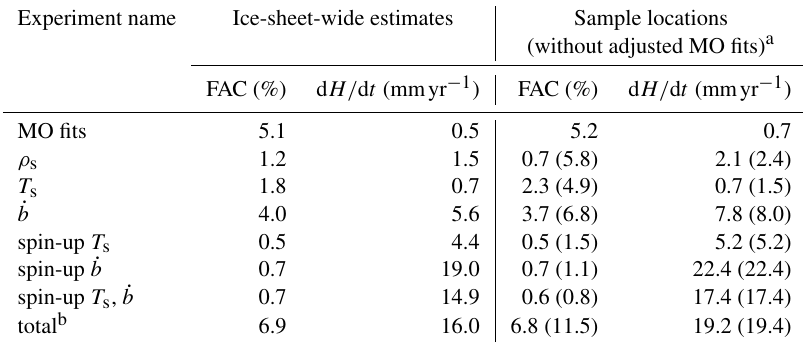
Table 5. Overview of the relative change in annual average firn air content (FAC) and surface elevation change (d H/ d t ) of the ice-sheet-wide estimates and sample location experiments. The sample location experiments also include the experiments without adjusted MO fits. The FAC uncertainty for all experiments and surface elevation change uncertainty for the spin-up experiments are calculated over 1979–2020, and the surface elevation change uncertainty for the MO fits, ρ s , T s and ˙ b experiments are calculated over 2015–2020. An overview of the experiments including the prescribed uncertainties are listed in Table